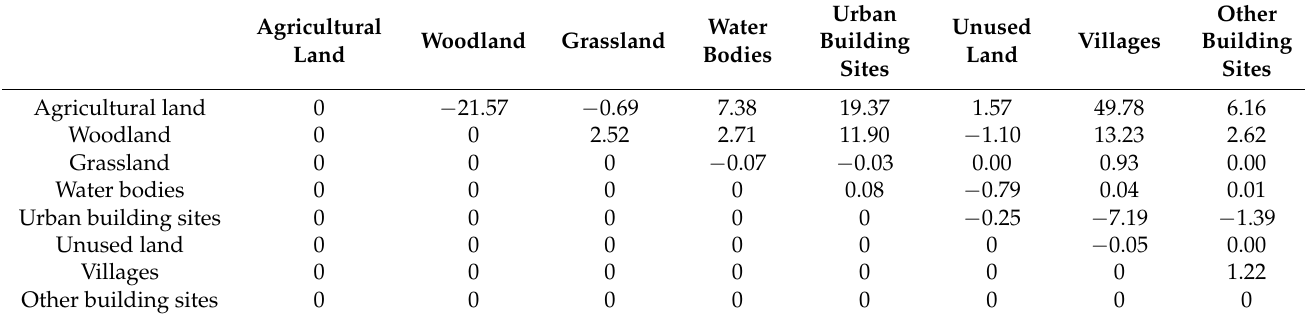
Table 7. Net land use transfer matrix between [5, 10] km buffer zone in Dalian.